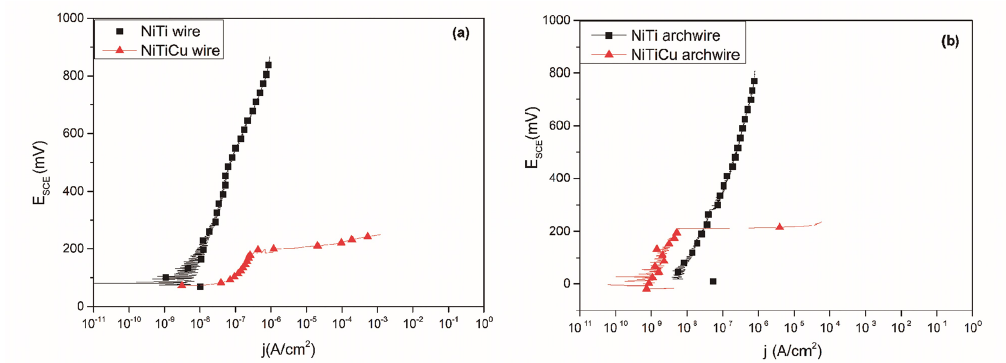
Figure 2. Anodic polarization of raw materials (a) and commercial archwires (b) in 0.9% NaCl Table 1. Electrochemical parameters of raw materials and commercial archwires. Alloy